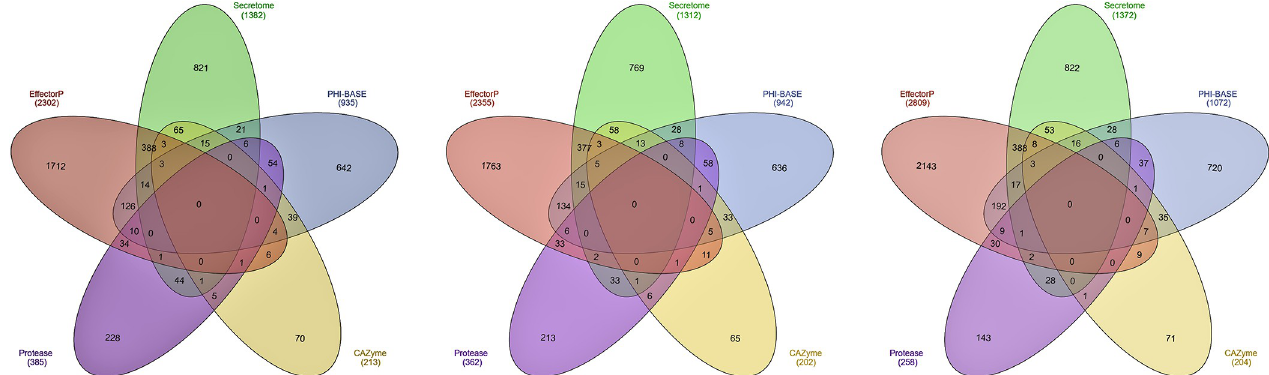
Fig 3. Distribution of genes among the different pathogenicity classes of secretome, effector, PHI-base homologs, proteases and CAZymes in A) Pst110S119, B) Pst78S84 and C) Pst46S119.